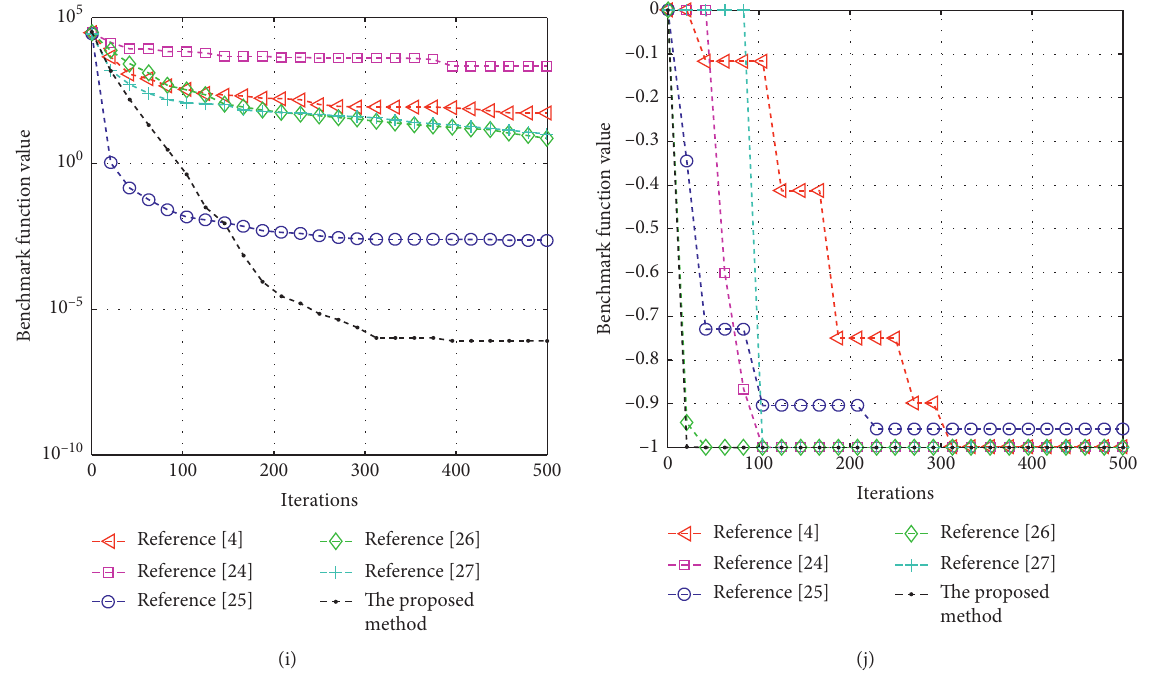
Figure 2: Unimodal function simulation results diagram. (a) f : Sphere ( d � 10 ) , (e) f f 2 : Easom ( d � 2 ) (j) f 4